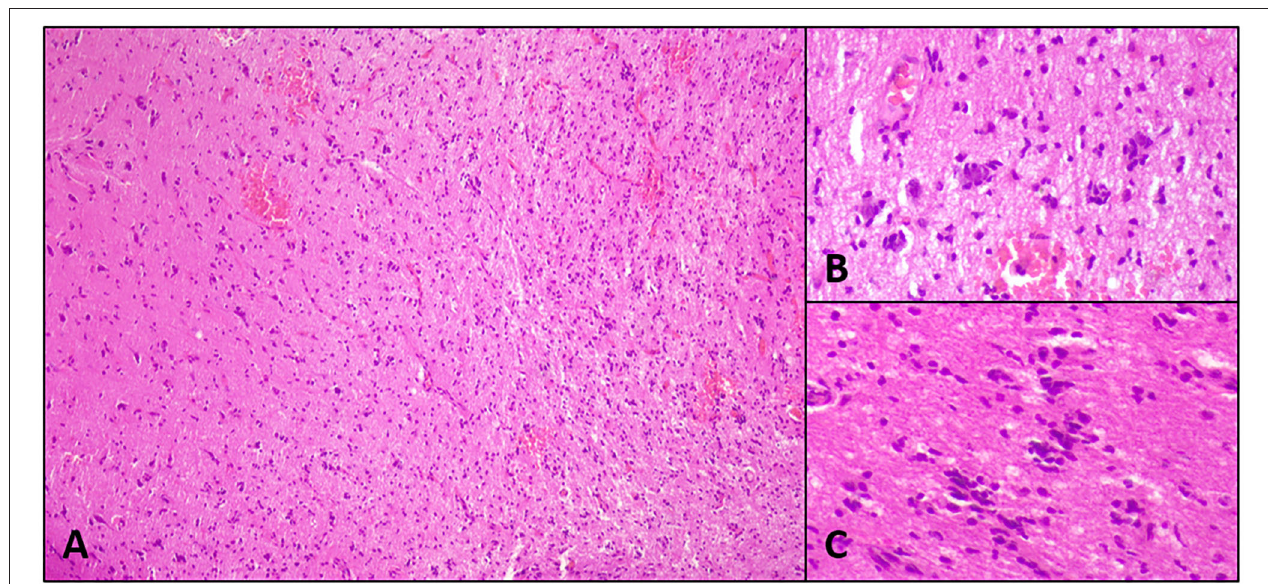
FIGURE 4 | Histopathological images of case 1: Diffuse low-grade spindeloid glioma with sparing of gray matter (A) , perineural (B) , and perivascular (C) structures of Scherer. The cells present with moderate cellular atypia, ovoid to elongated nuclei, stippled chromatin, unremarkable nucleoli, and invisible cell borders. Mitoses are not seen. The cells stained negative for GFAP, MAP2, and